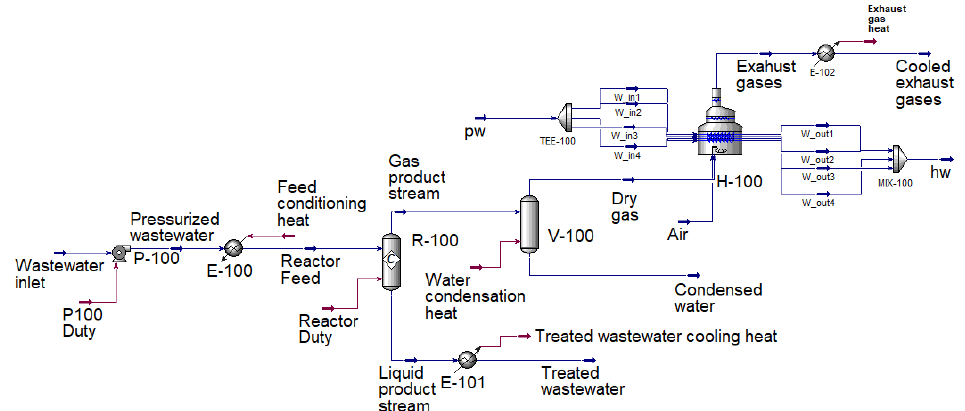
Figure 2. Aspen HYSYS process flow diagram used for heat-balance analysis.